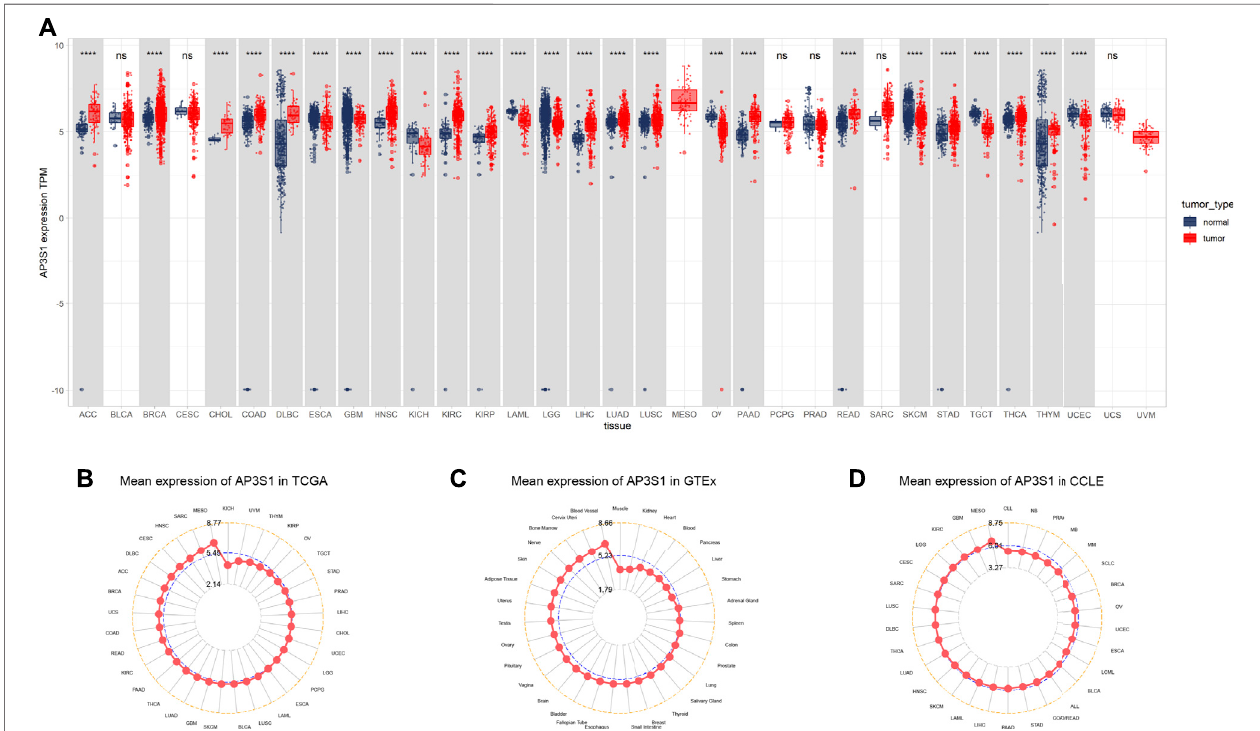
FIGURE 1 | Expression of AP3S1 in pan-cancer. (A) pan-cancer expression of AP3S1. (B) AP3S1 expression in tumor tissues from TCGA cohort. (C) AP3S1 expression in normal tissues from GTEx cohort. (D) AP3S1 expression in cancer cell lines from the CCLE cohort.* p < 0.05, ** p < 0.01, *** p < 0.001, **** p < 0.0001.